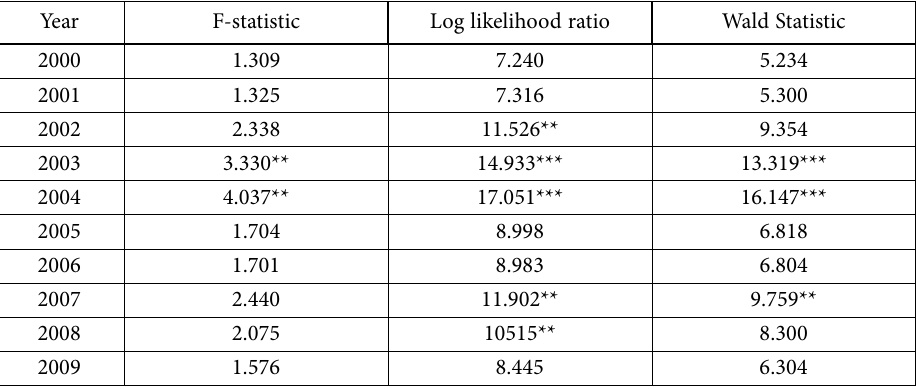
Table 6. Chow Breakpoint test (source: authors’ own processing) Year F-statistic Log likelihood ratio Wald Statistic 2000 1.309